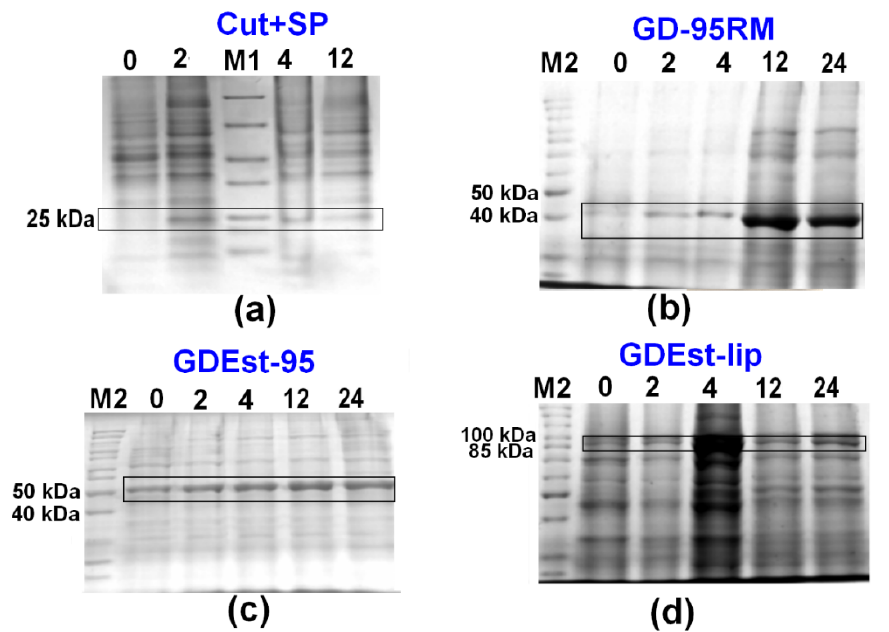
Figure 6. Analysis of production of recombinant Cut+SP ( a ), GD-95RM ( b ), GDEst-95 ( c ), and GDEst-lip ( d ) enzymes in 2 L mM9 cultivation medium without additional supplementation with ampicillin and using MP (4 mM) as an inducer. M1—Pierce™ Unstained Protein MW Marker; M2— PageRuler™ Unstained Protein Ladder; 0/2/4/12/24—time point after induction with MP (in hours). The target enzymes are marked with black boxes. Tricine-SDS-PAGE was used for Cut+SP analysis and glycine-SDS-PAGE for GD-95RM, GDEst-95, and GDEst-lip.